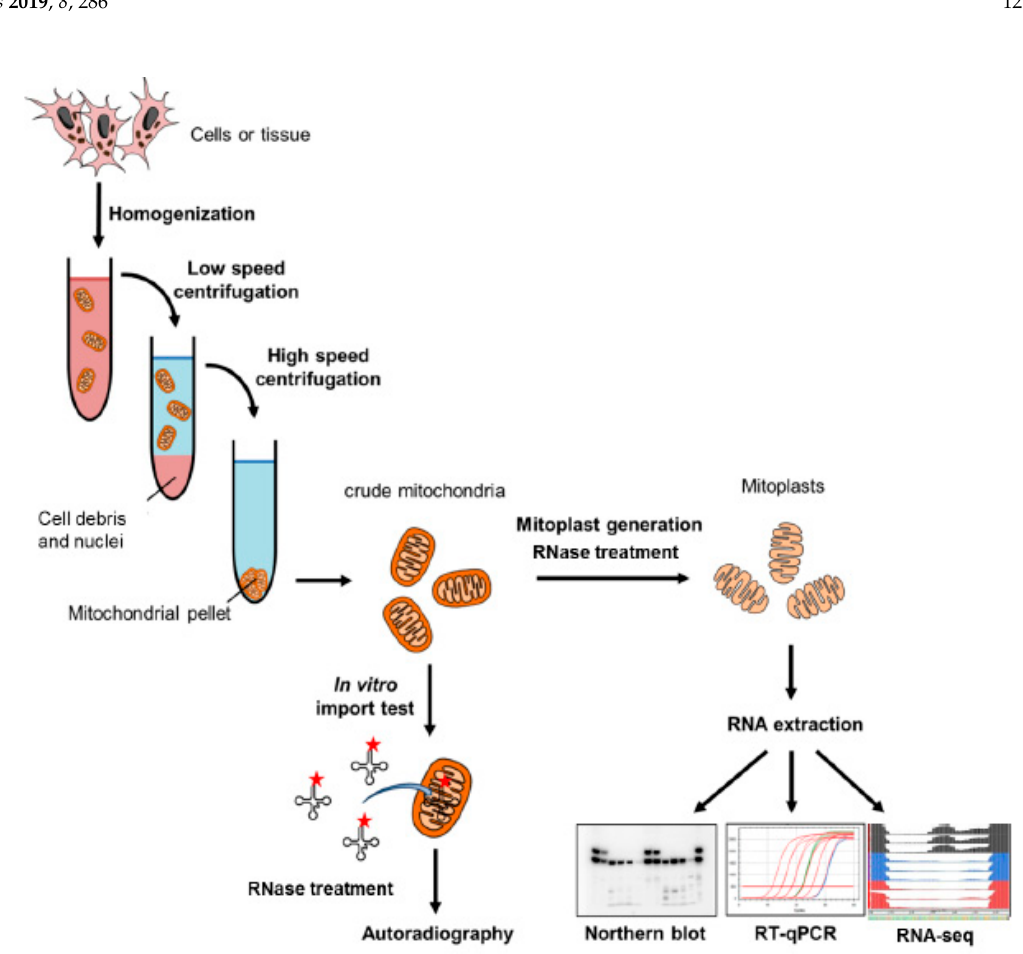
Figure 5. Analysis of mitochondrial RNA import by subcellular fractionation and in vitro import assay. Isolated mitochondria can be obtained by cell or tissue homogenization followed by differential centrifugation (as shown here) or antibody-mediated capture. Crude mitochondria can be used for in vitro import tests with radiolabeled transcripts or further purified to analyze endogenous mitochondria-localized RNAs.